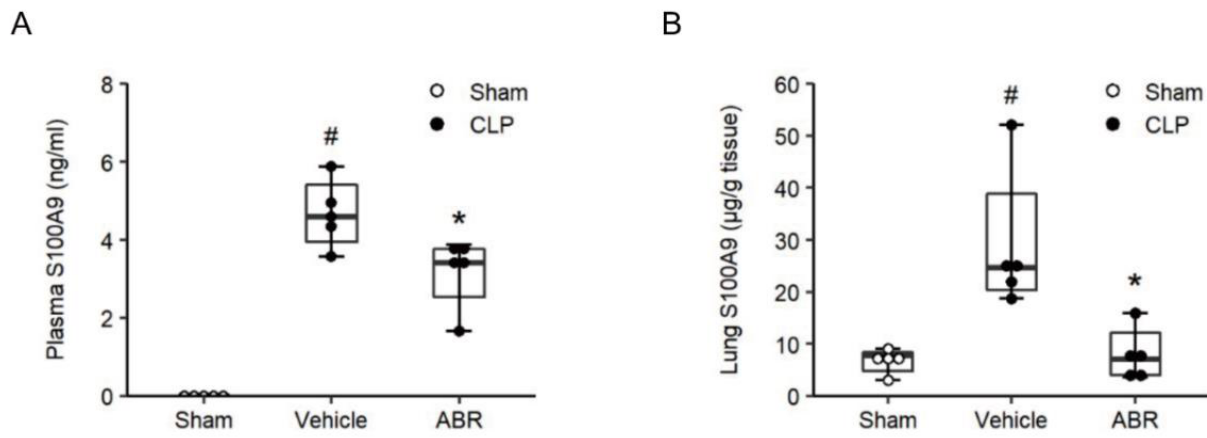
Figure 1. Levels of S100A9 in plasma and lung. Mice were pre-treated with intraperitoneal injections of the vehicle or ABR-238901 (10 mg/kg) 1 h before Sham or CLP operation. Levels of S100A9 in ( A ) plasma and ( B ) lung were determined 24 h after CLP induction. Data are presented as box plots with median (25 – 75 percentile) and the whiskers extend from the minimum to the maximum levels and dots represent sample values. # p < 0.05 vs. Sham, and * p < 0.05 vs. Vehicle, n = 5.